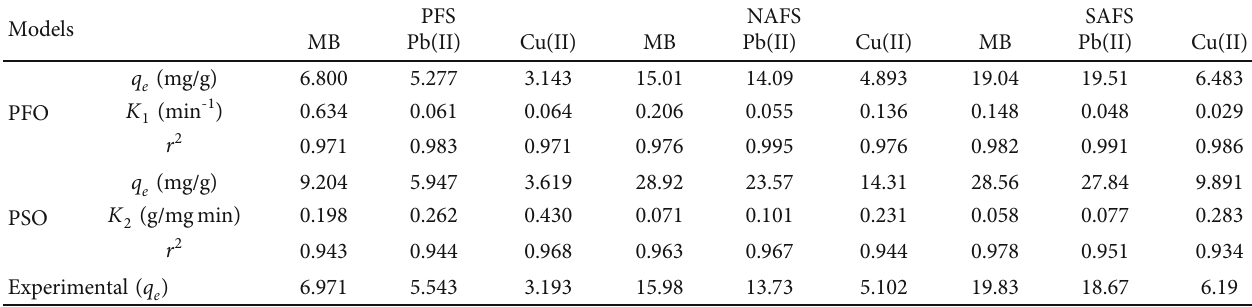
Table 5: Di ff usion parameter for the removal of Pb(II), Cu(II), and MB onto PFS, NAFS and